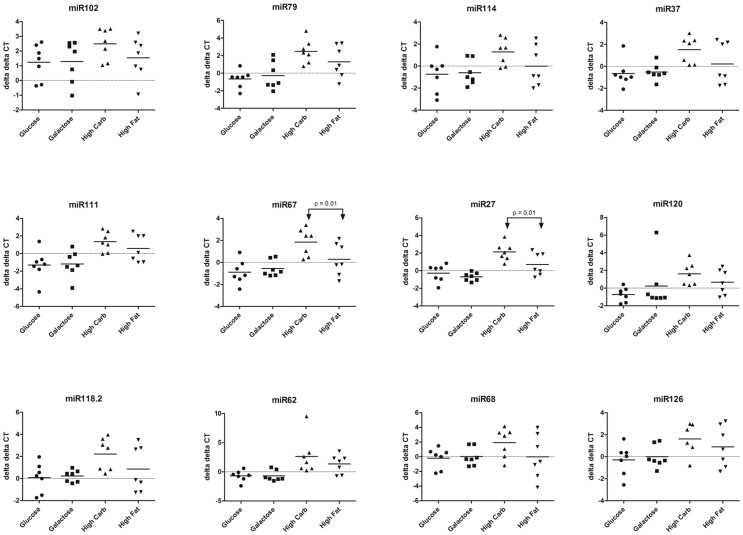
Delta delta CT comparing between rhGH (normalization) cohorts and dietary manipulated cohorts.When normalized to rhGH synchronized lean subjects, no significant differences were observed among obese lactating women on either high glucose or high galactose dietary manipulations. However, novel- miR-67 and novel-miR-27 species were observed to vary significantly (p = 0.01) following introduction of a maternal high fat diet in lean subject cohorts. This data is represented as fold change of cohorts with ANOVA for significance in Table S19.